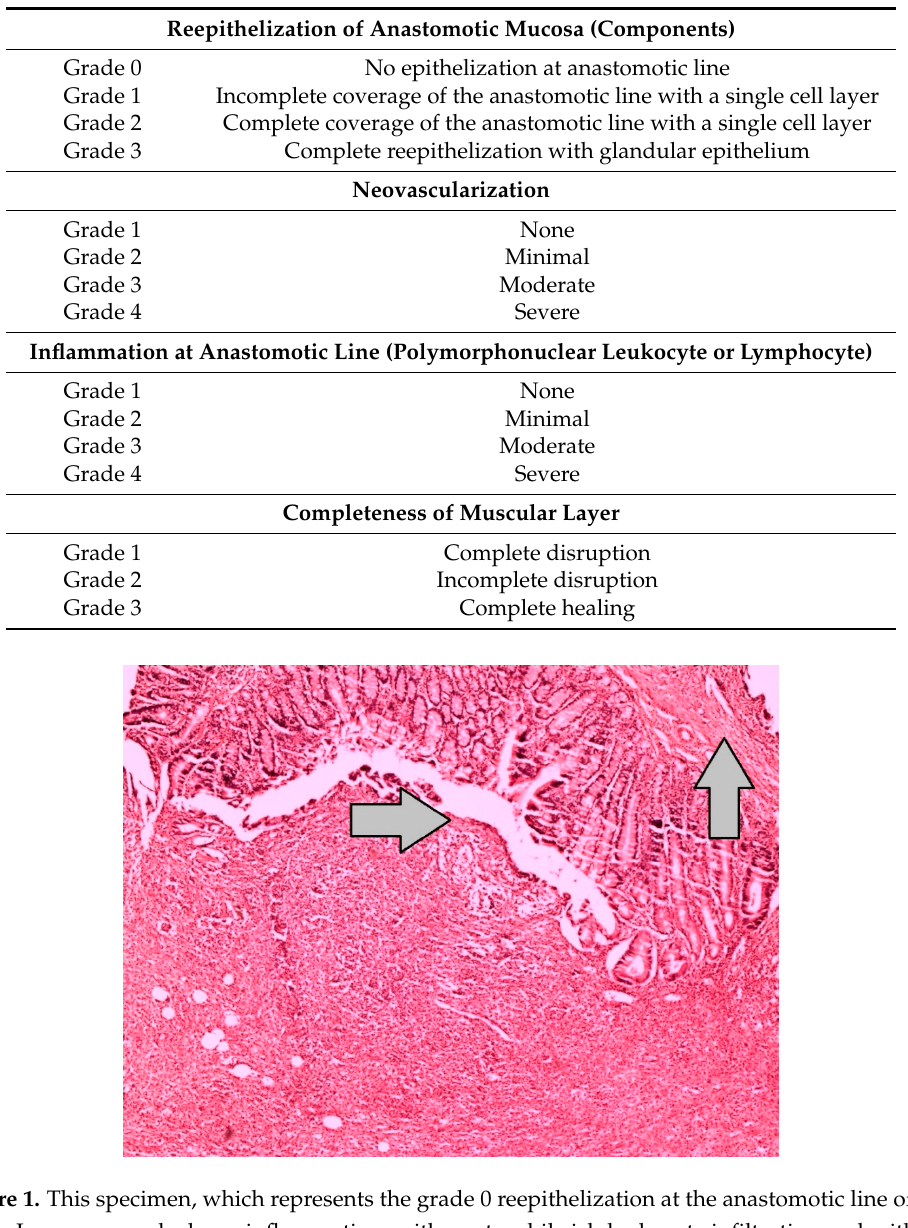
Table 1. Descriptive table of the histopathological grading scores [8].